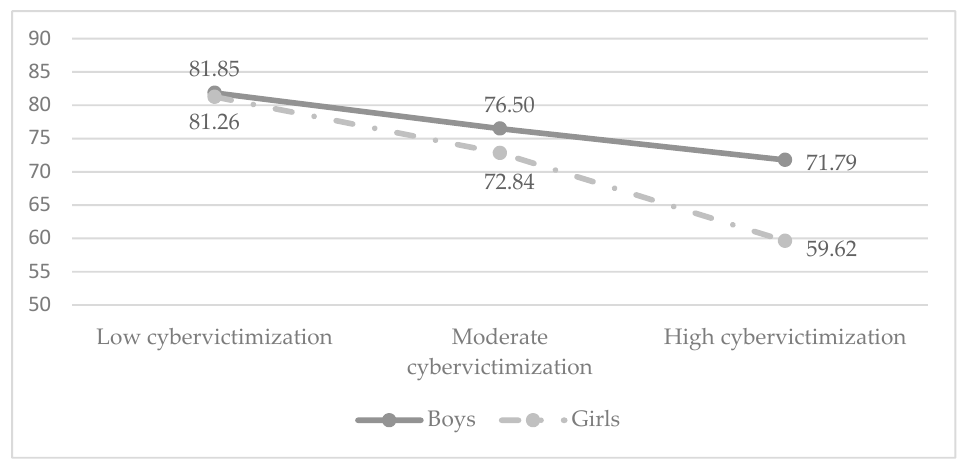
Figure 2. Cybervictimization, family self ‐ concept and gender.